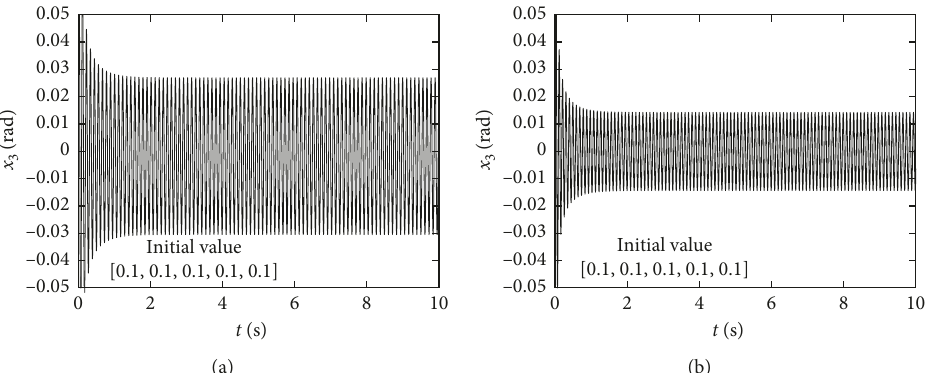
Figure 11: Amplitude comparison of nonlinear gain of controlled systems at different time scales: (a) k